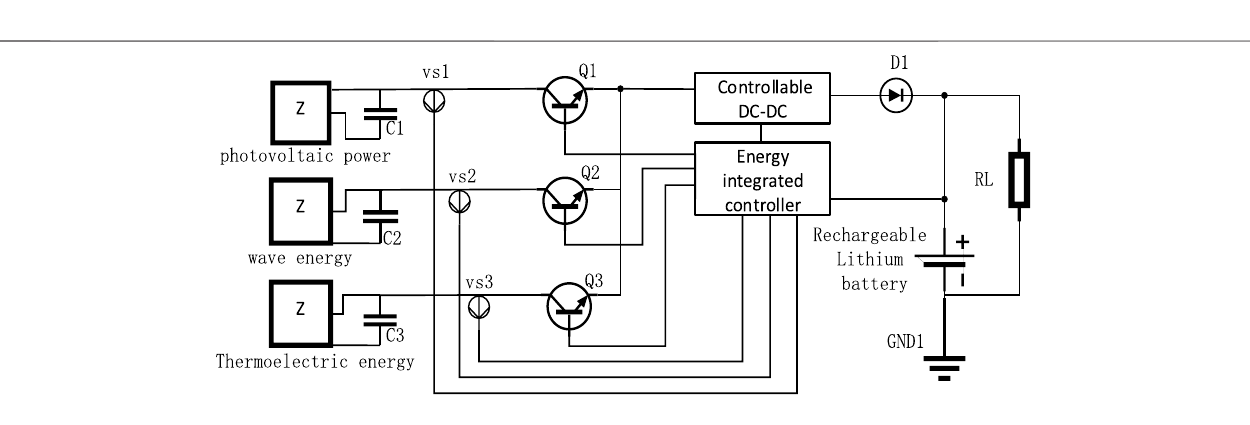
FIGURE 12 | Energy management circuit